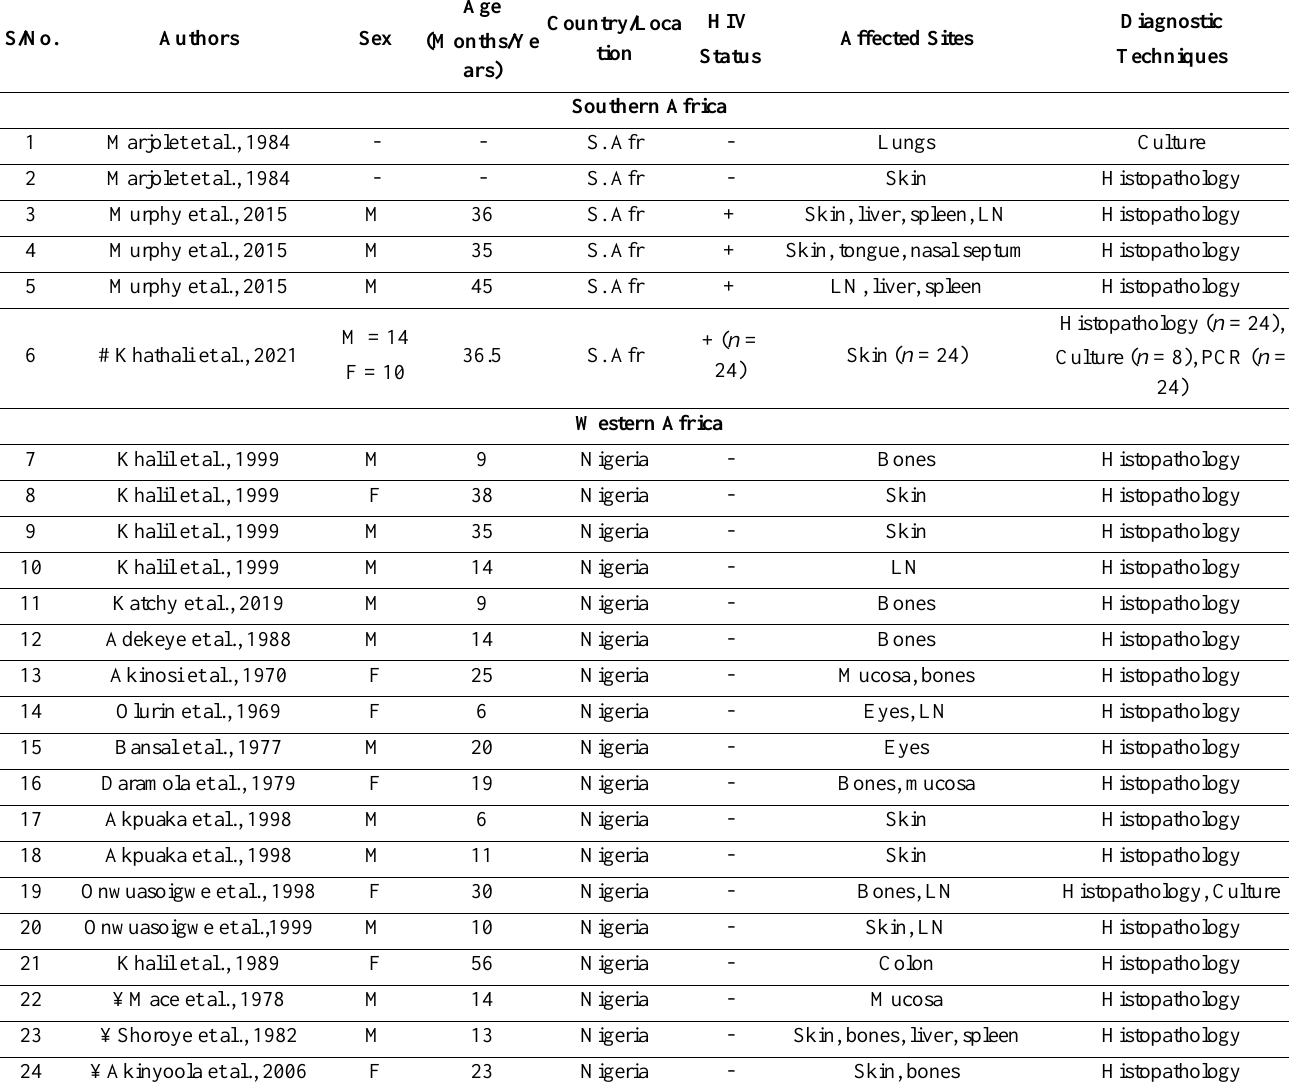
Supplementary Table 1: Clinical summary and demographics of 307 cases of Hcd infection (1950–2021).